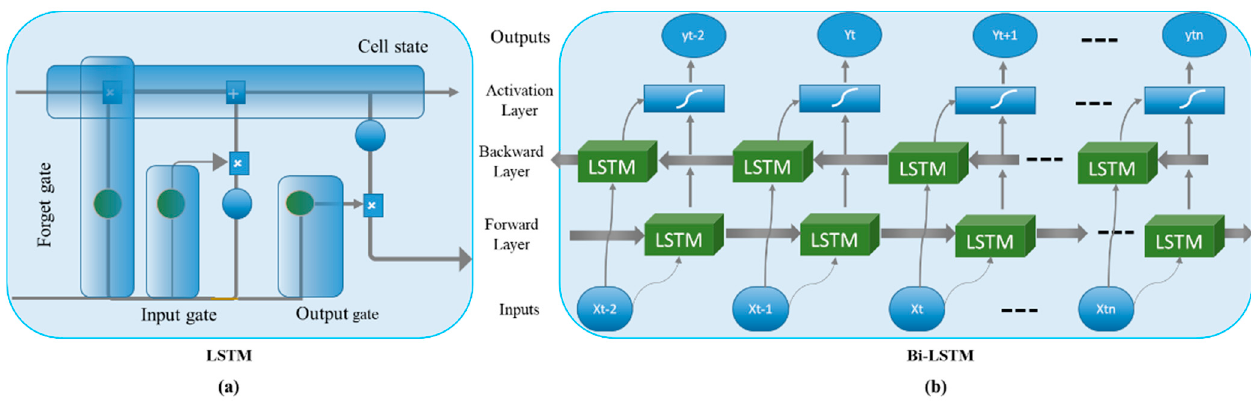
Figure 3. Internal architecture of sequential learning methods. ( a ) The internal architecture of the LSTM and the data flow using the internal gates. ( b ) Bi-LSTM with input, internal layers, and output layers showing forward and backward passes. Here, W xi , W hi , W ci , W f , W hf , W cf , W xo , W ho , and W co show the weights, while b i , b f , b C , and b o represent bias vectors. x t indicates the current input while t1 and h t − 1 show